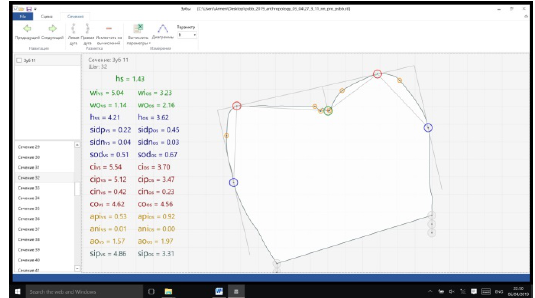
Figure 1. Tooth section with odontometric landmarks tometrical descriptions of dental morphological features; among such are tooth contour lengths, their eminences, inclination an- gles and